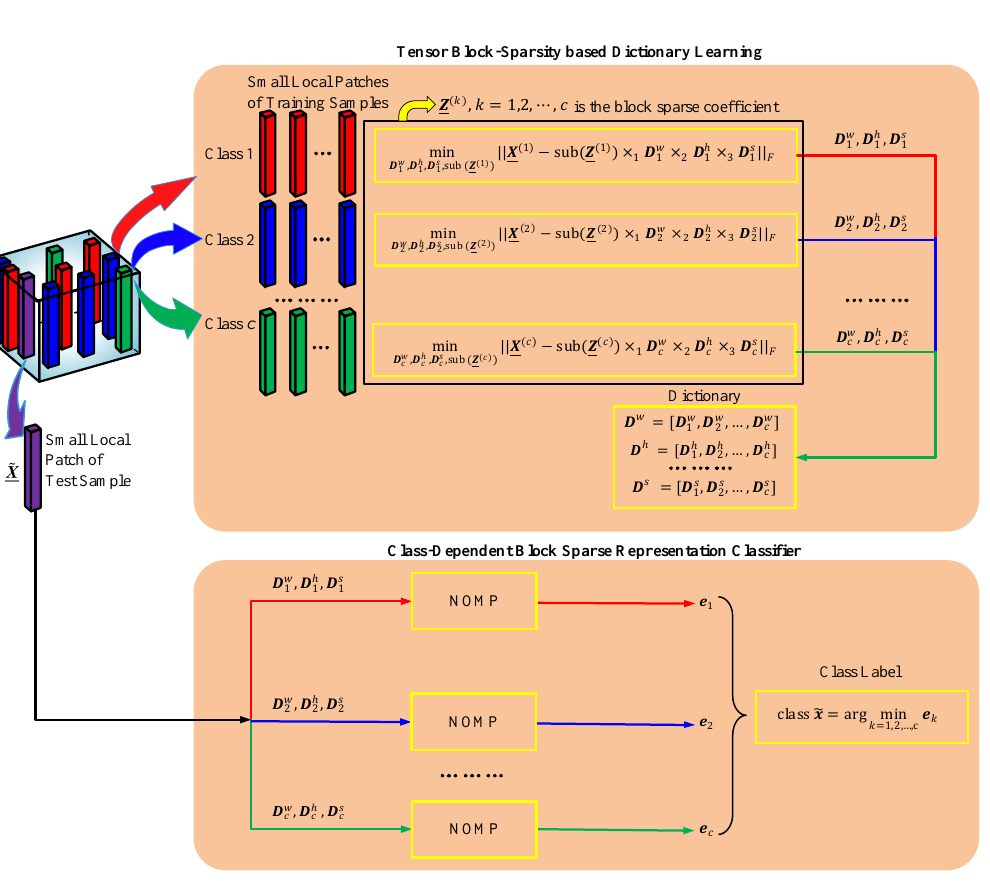
Figure 2. Flowchart of the proposed algorithm. In each class, Z ( k ) share the same atoms of dictionaries ( D w ) , thus making the dictionary learning process tensor , D h , D s k k k